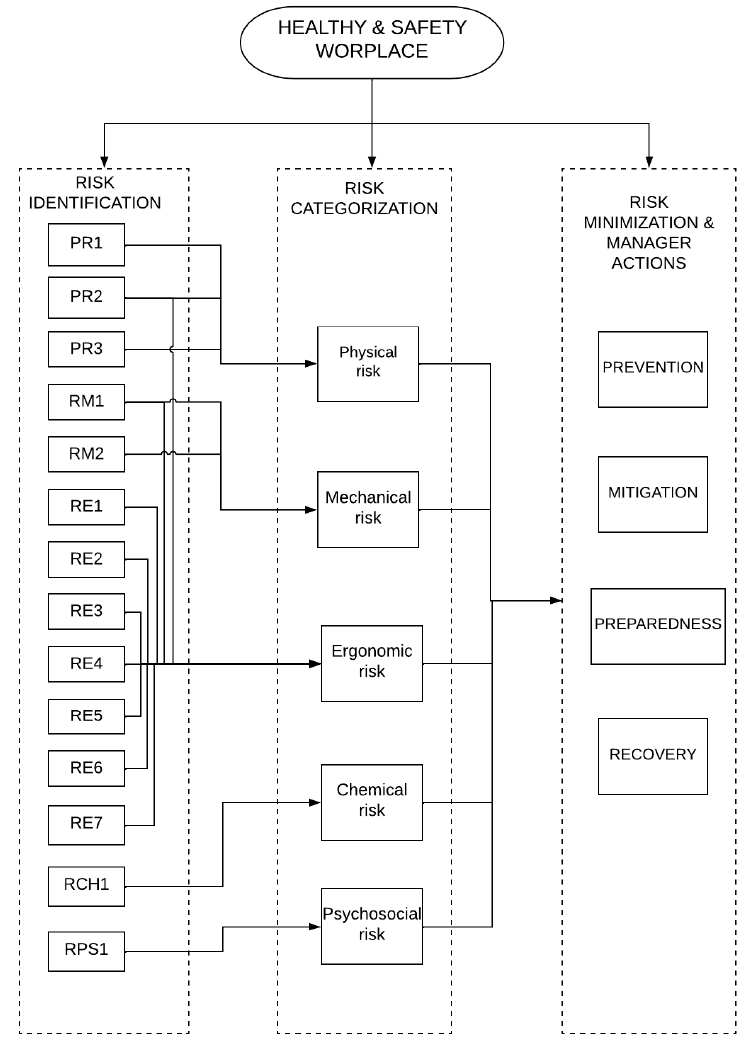
Appl. Sci. 2022 , 12 , x FOR PEER REVIEW Figure 2. Risk relation and definition. Figure 2. Risk relation and definition.